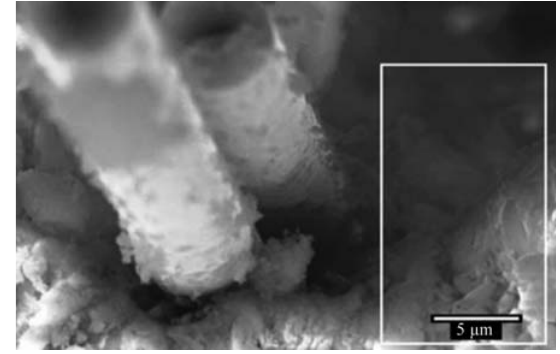
Figure 9 SEM micrograph of the interface (specimen